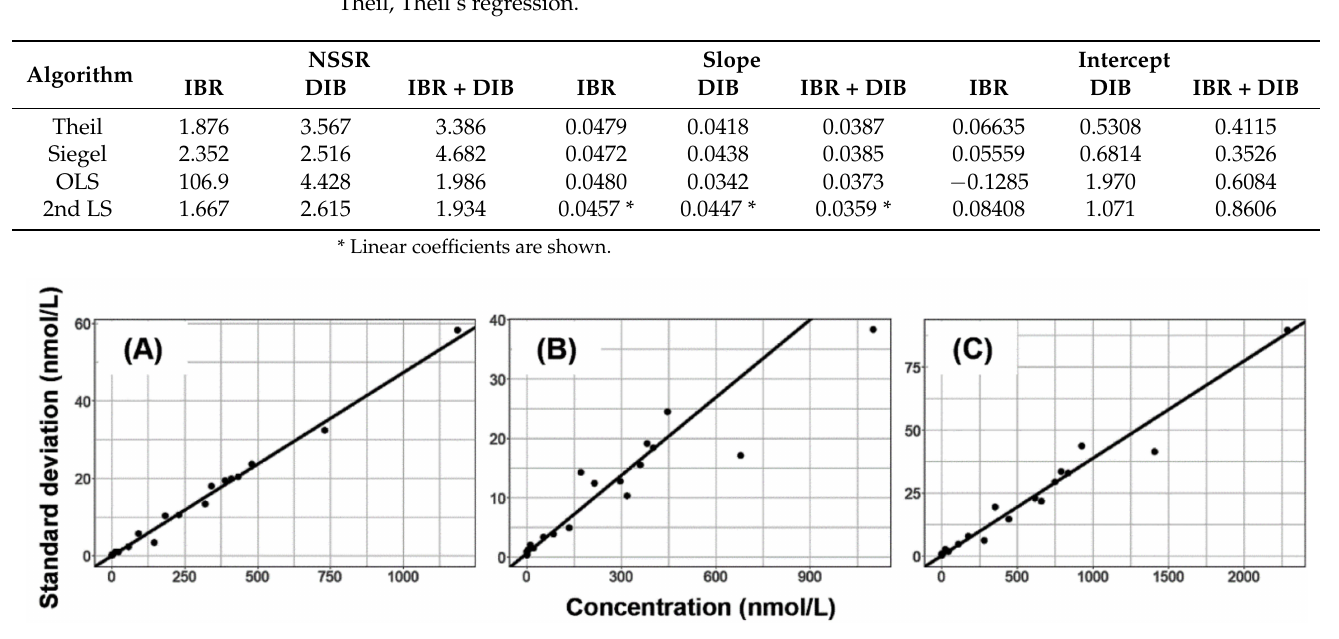
Table 4. Performance of regression algorithms applied to the concentration–standard deviation rela- tionships. IBR, ibrutinib. DIB, dihydrodiol ibrutinib. IBR + DIB, sum of IBR and DIB concentrations (active moiety). NSSR, normalized sum of squared residuals. OLS, unweighted linear least squares. 2nd LS, unweighted 2nd-degree least squares. Siegel, Theil’s regression with the Siegel estimator. Theil, Theil’s regression.